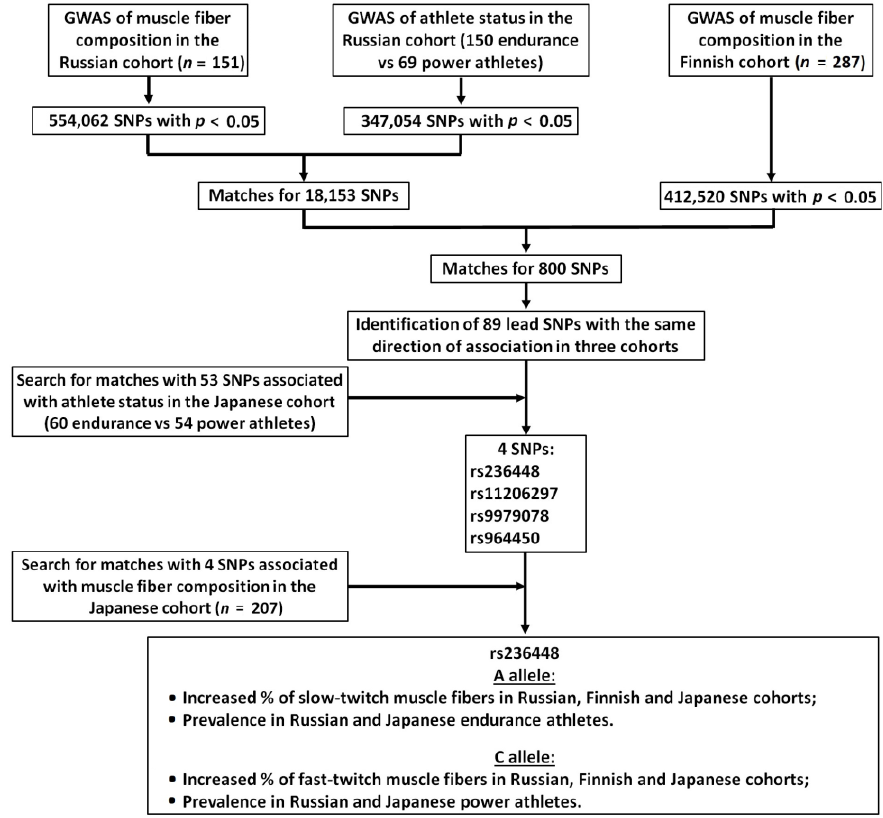
Figure 1. A schematic overview of the study design and findings.